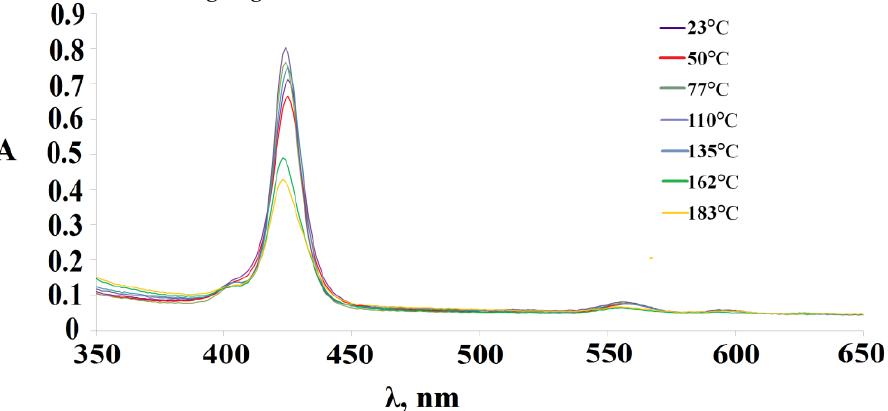
Figure 10. Changes in the UV − vis spectra of the (Sn(L) 2 P) 4 (PdCl 2 ) 4 (compound 3) when the tempera- ture of the DMSO solution varies from 23 ◦ Cto 183 ◦